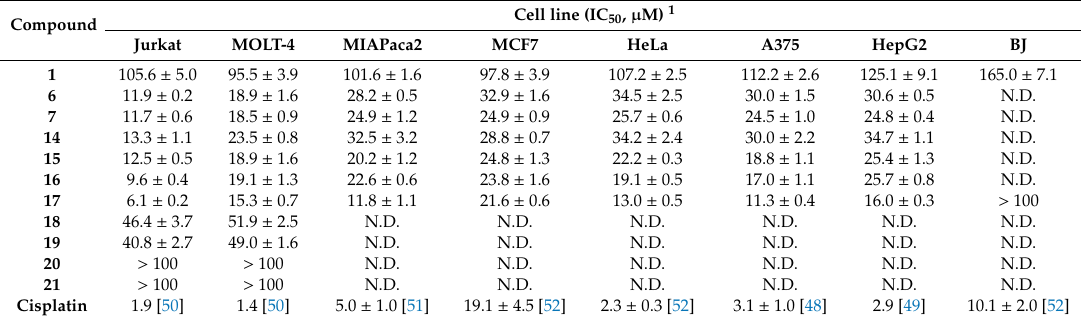
Table 2. Antiproliferative activities of GA 1 , its derivatives 6 , 7 and 14–21 , and cisplatin against several cancer cell lines and the human nontumoral BJ cell